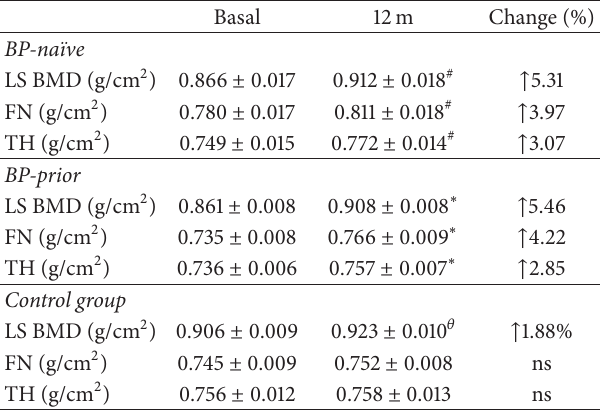
Table 3: BMD in patients treated with Dmab (BP-na¨ıve and BP- prior) and BP treated patients not switched to Dmab (control